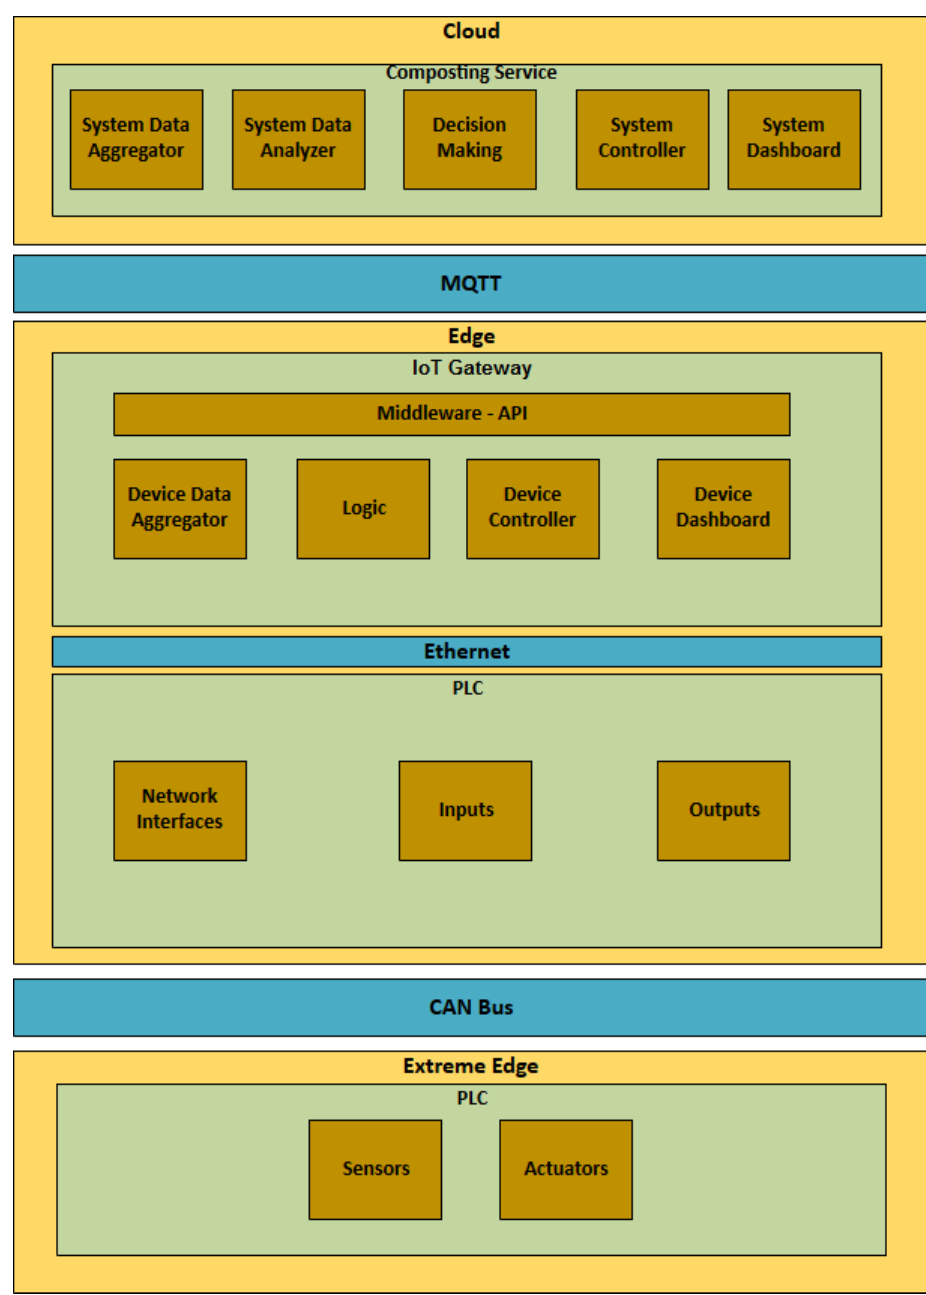
Figure 3. System